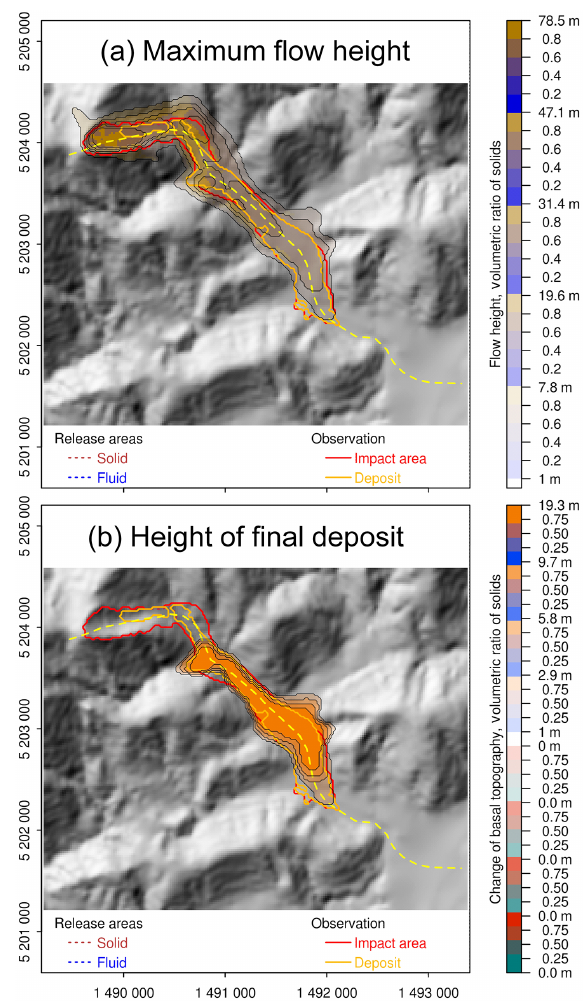
Figure 12. Results of Experiment 2B. (a) Maximum flow height H Max ; (b) height of final deposit H D (as entrainment is not consid- ered, H D = H C ). Note that, due to the predominance of solids, the bluish and greenish colours indicated in the legend do not appear in the map (see Figs.